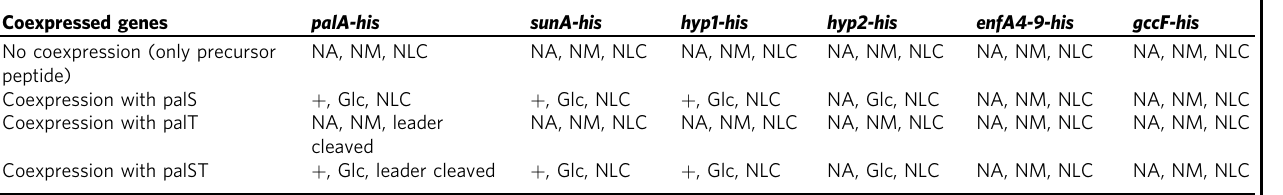
Coexpression with palST Glc refers to the peptide ’ s modi fi cation with a mass of + 162; plus symbol refers to the presence of antibacterial activity of the puri fi ed peptide NA no activity, NM no modi fi cations, NLC no leader cleavage, palA-his pallidocin precursor, sunA-his sublancin precursor, hyp1-his putative glycocin precursor Hyp1, hyp2-his putative glycocin